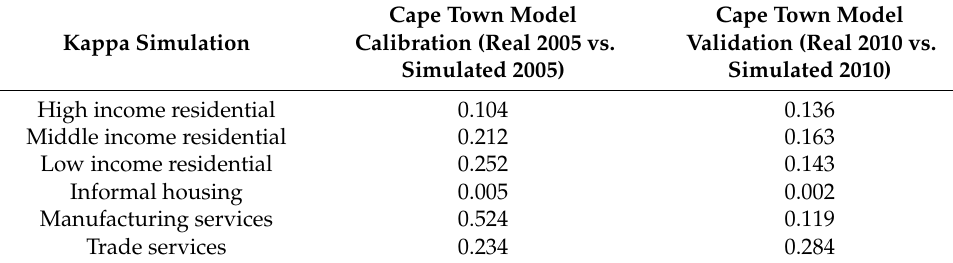
Table 3. Kappa Simulation results for the calibration and validation